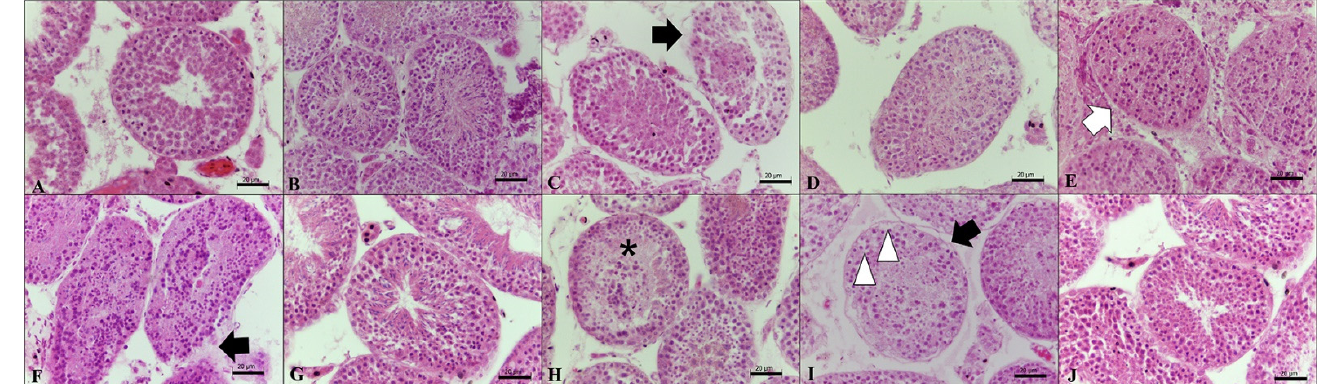
Figure 1. Representative micrographs used for histomorphological evaluations of testicular tissue sections from adult red-rumped agoutis (n = 5 males) after different cryopreservation treatments. ( A ) Non-cryopreserved control group, and cryopreserved groups using ( B ) slow freezing [SF] with dimethyl sulfoxide [DMSO], ( C ) SF with ethylene glycol [EG], ( D ) SF with DMSO + EG, ( E ) solid-surface vitrification [SSV] with DMSO, ( F ) SSV with EG, ( G ) SSV with EG + DMSO, ( H ) conventional vitrification [CV] with DMSO, ( I ) CV with EG, ( J ) CV with DMSO + EG. Black arrows indicate rupture from the basal membrane. White arrow shows shrinkage from the basal membrane. Asterisks shows tubular cell loss. White arrowheads show cell swelling. Scale bar: 20 µm.